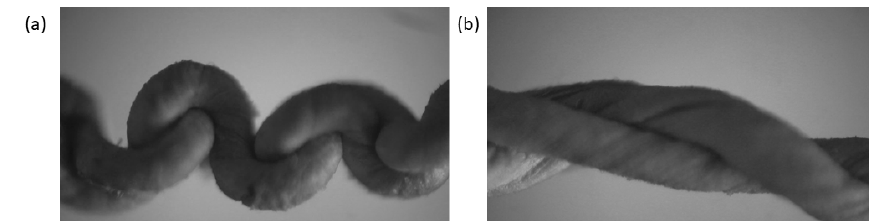
Figure 6. Optical microscope image of the TPU/graphene strain sensor with an intertwined-coil configuration under ( a ) 400% strain and ( b ) 800% strain.